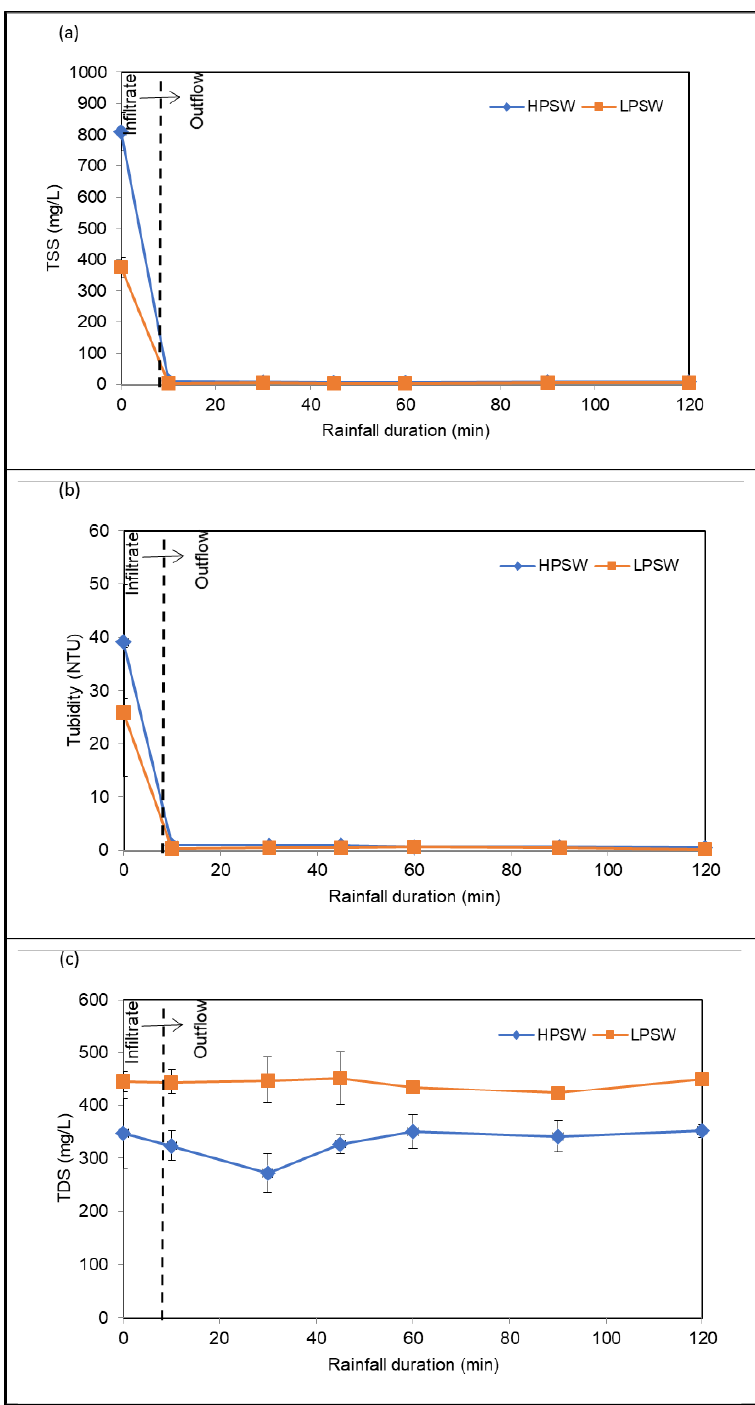
Figure 4. Variations of ( a ) TSS, ( b ) turbidity, and ( c ) TDS before and after infiltration through permeable clay bricks.